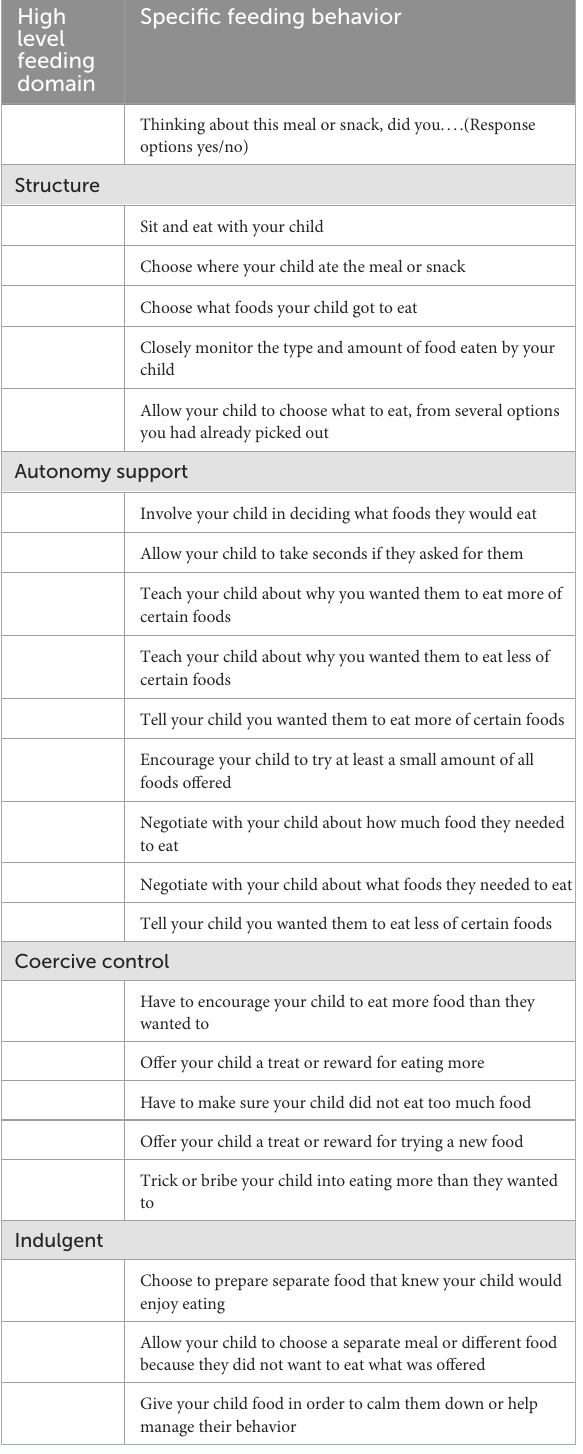
TABLE 2 Individual items from the EMA-based real-time parent feeding practices survey. High Specific feeding level feeding domain